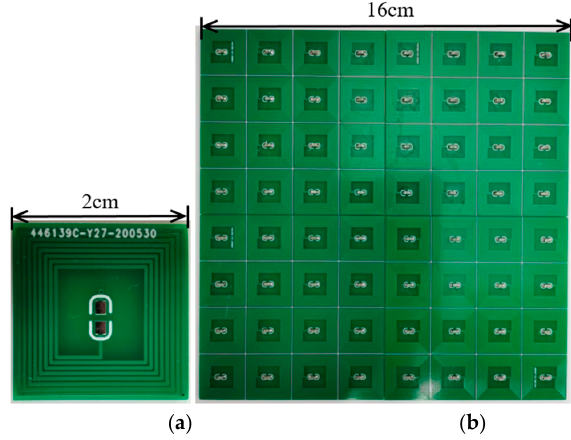
Figure 5. The fabricated MTMs, ( a ) the MTM unit. ( b ) The MTM slab.